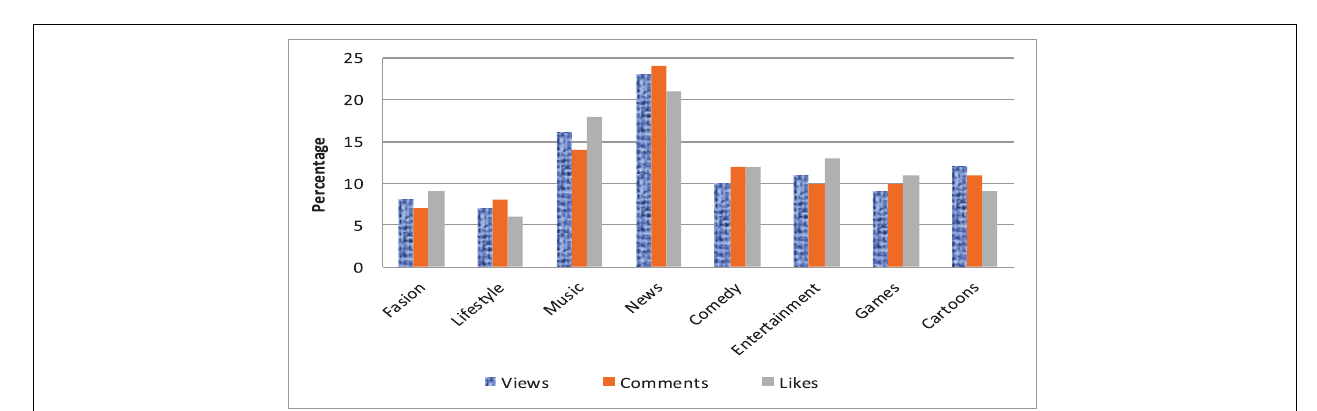
FIGURE 4 | Country-wise comments and likes.